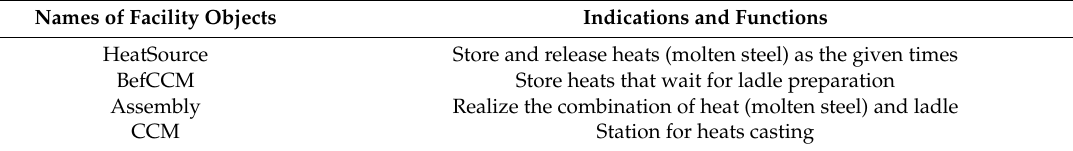
Figure 1. Static model based on a typical workshop layout. Table 1. Main facility objects in model and their corresponding indication and function.